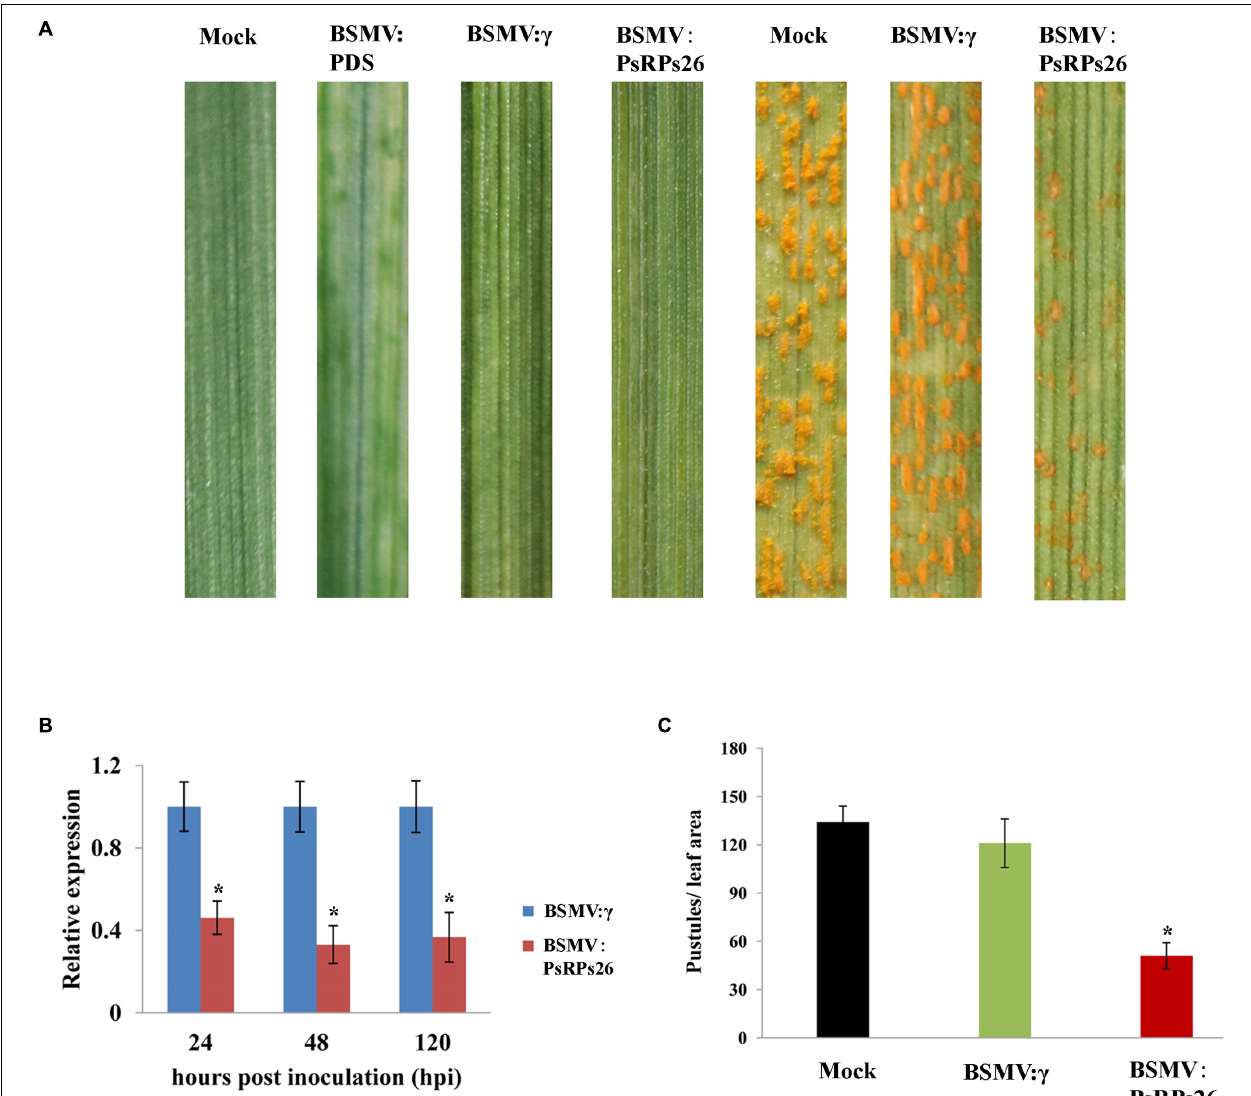
FIGURE 4 | Functional characterization of PsRPs26 during the interaction between wheat and stripe rust using host-induced gene silencing. (A) Phenotypic changes in the fourth leaves of plants pre-inoculated with the positive control vector (BSMV-PDS), FES buffer (CK), or empty BSMV vector (BSMV: γ ). Phenotypes for the fourth leaves inoculated with the P. striiformis f. sp. tritici ( Pst ) CYR31 race at 14 dpi. (B) Relative transcript levels of PsRPs26 in the silenced leaves. BSMV: γ leaves infected with the Pst CYR31 race were used as a control. (C) Quantification of uredinial density in PsRPs26 knockdown plants 14 dpi with the CYR31 isolate. Means and standard deviations were calculated from three independent replicates. Significant differences were determined using Student’s t -test: ∗ P < 0.05.